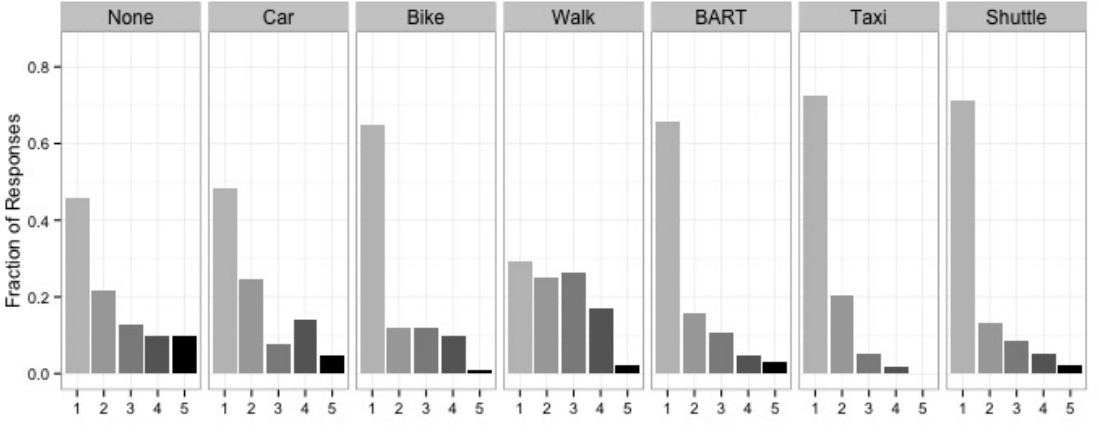
Figure 6. Increase in Muni use: Travel modes substituted with Muni trips. (1 - applies to none of the trips, 5 - applies to all